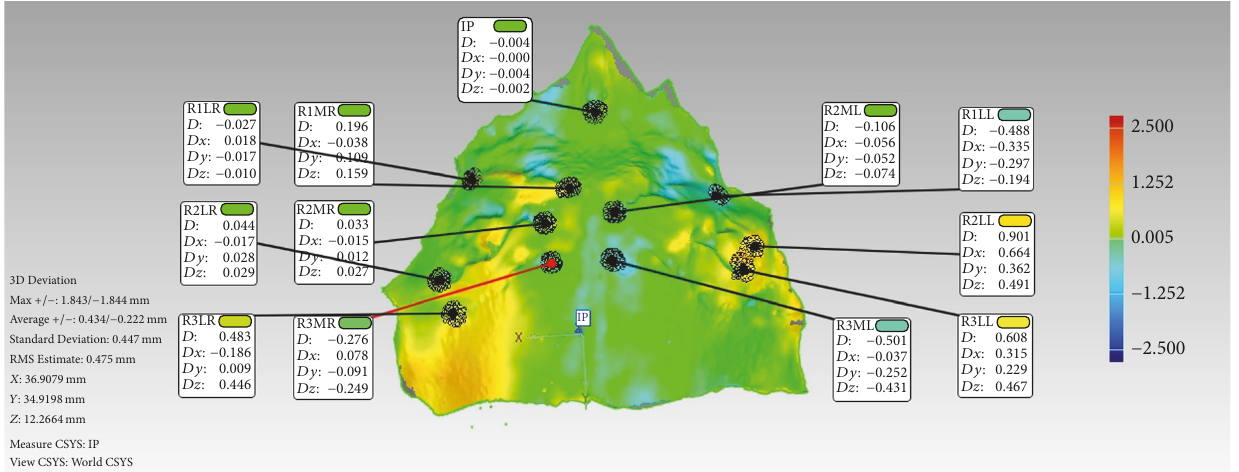
Figure 5: Annotation view with selected medial and lateral points of the palatal